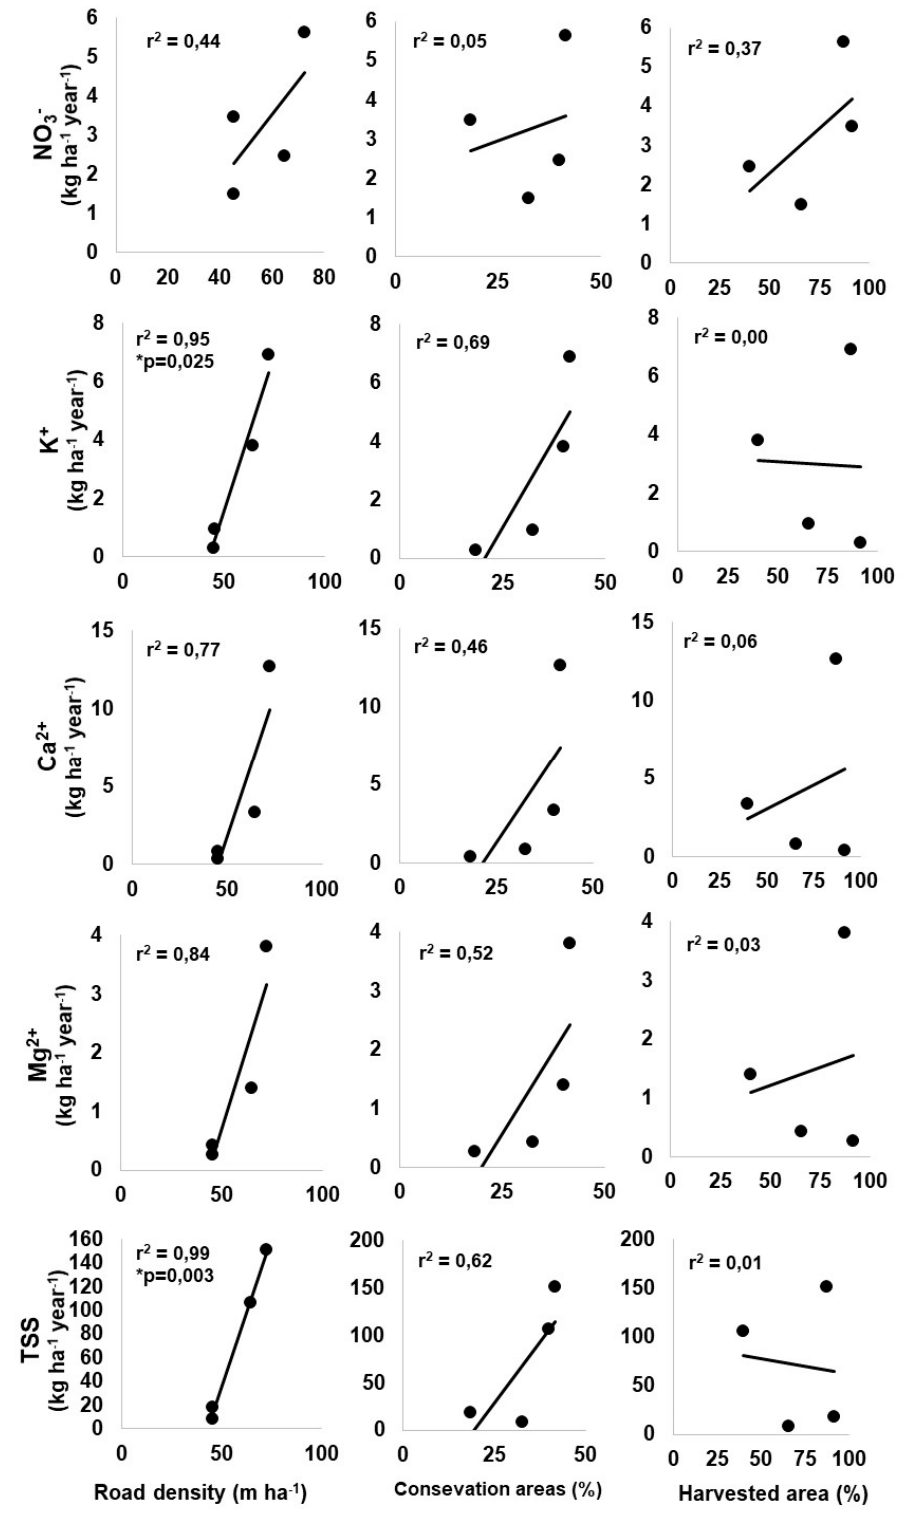
Figure 3. Exportation (kg ha − 1 year − 1 ) of nitrate (NO 3 − ), potassium (K + ), calcium (Ca 2+ ), magnesium (Mg 2+ ), and total suspended solids (TSS) obtained in the year after harvesting (AH) in relation to characteristics of forest management (road density, conservation areas and harvested area) of catchments C1, C2, C3, and C4. * denote relation statistically significant ( p < 0.05).